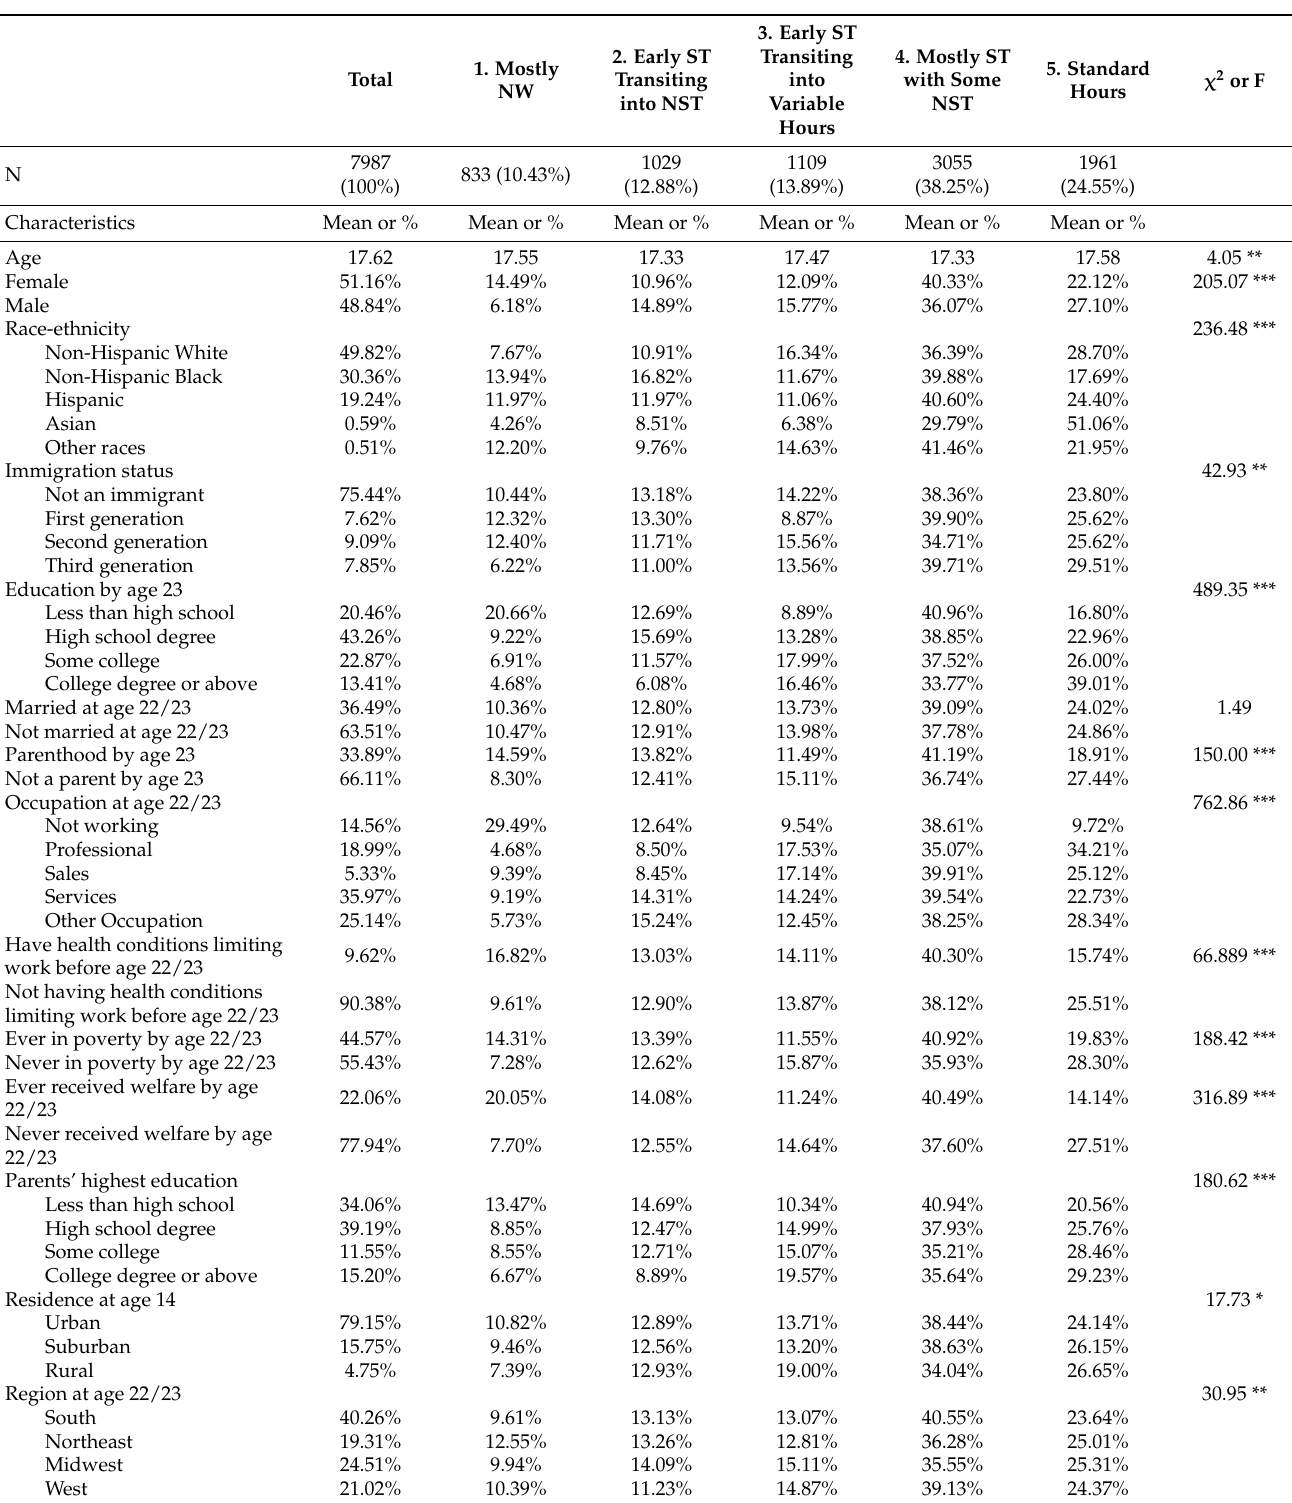
Table 1. Descriptive Statistics for Overall Sample and by